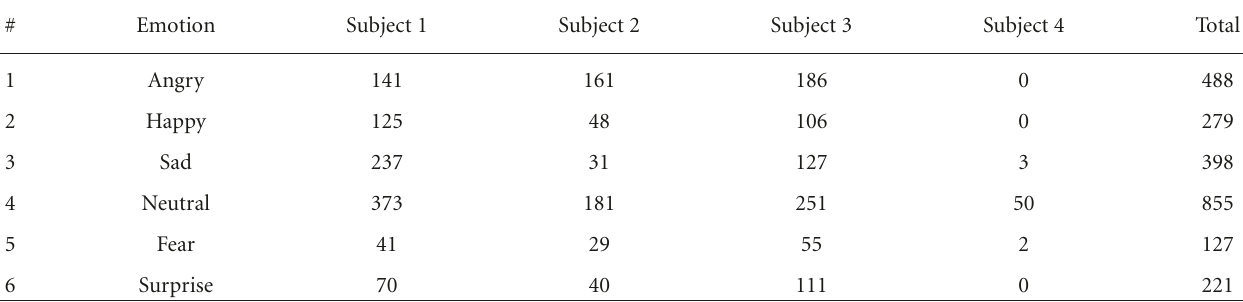
Table 1: Emotional utterances available in the Godot corpus.